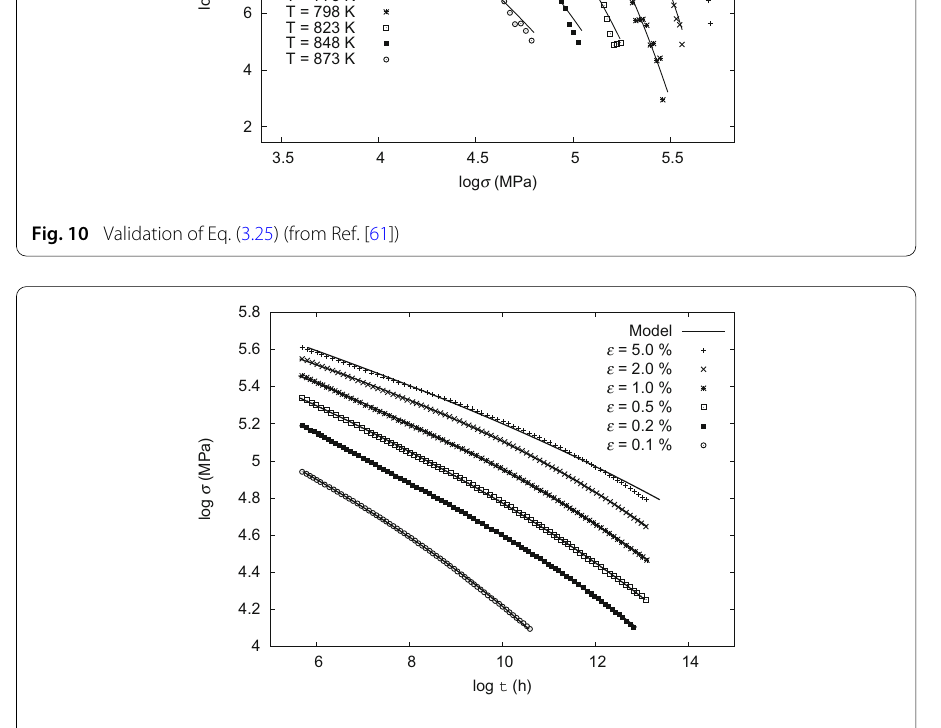
Fig. 11 Validation of Eq. (3.30) at T = 773K (from Ref. [61])